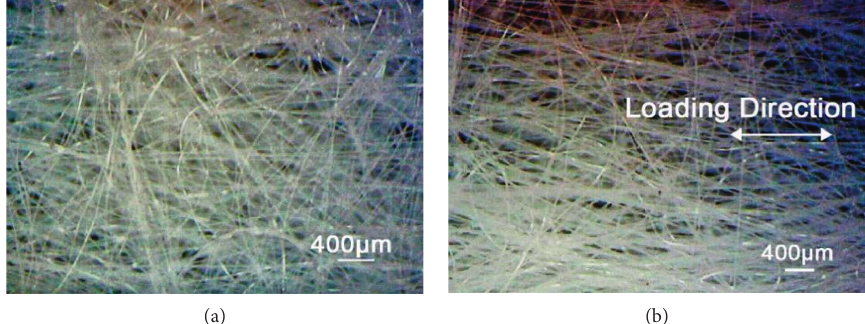
Figure 4: Microstructures of an NW100 geotextile specimen. (a) 0% strain. (b) 10% uniaxial tensile strain.